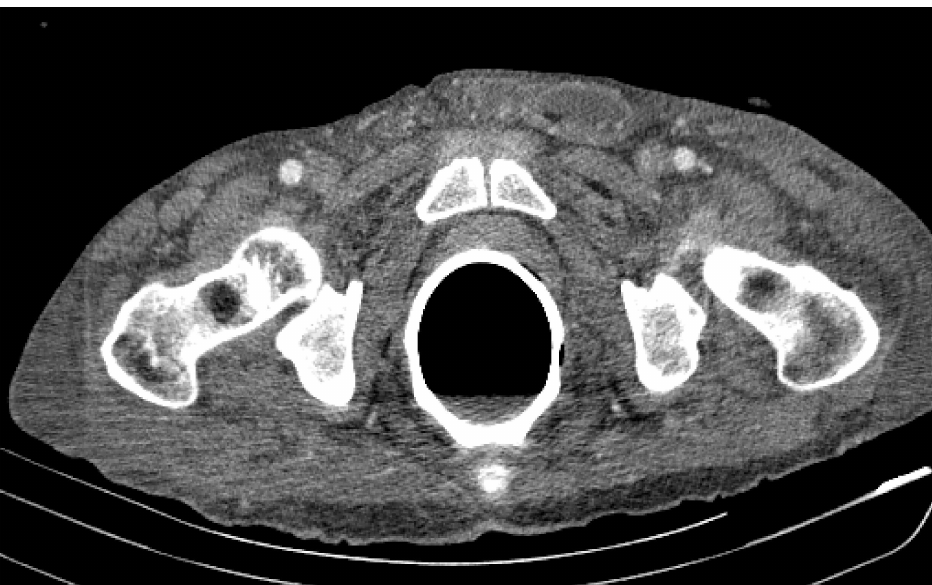
Figure 7. Patient’s computer tomography: the presence of a foreign body is highlighted.